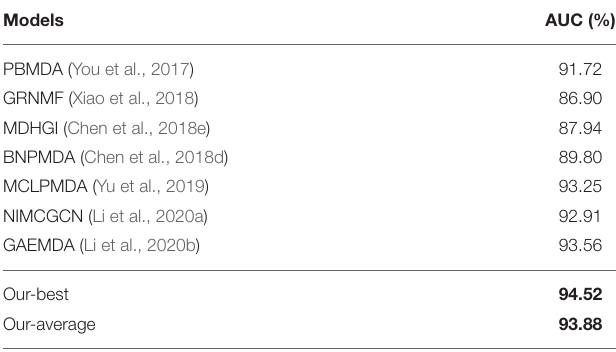
TABLE 4 | Top 50 predicted miRNAs related to Breast Neoplasms based on HMDD